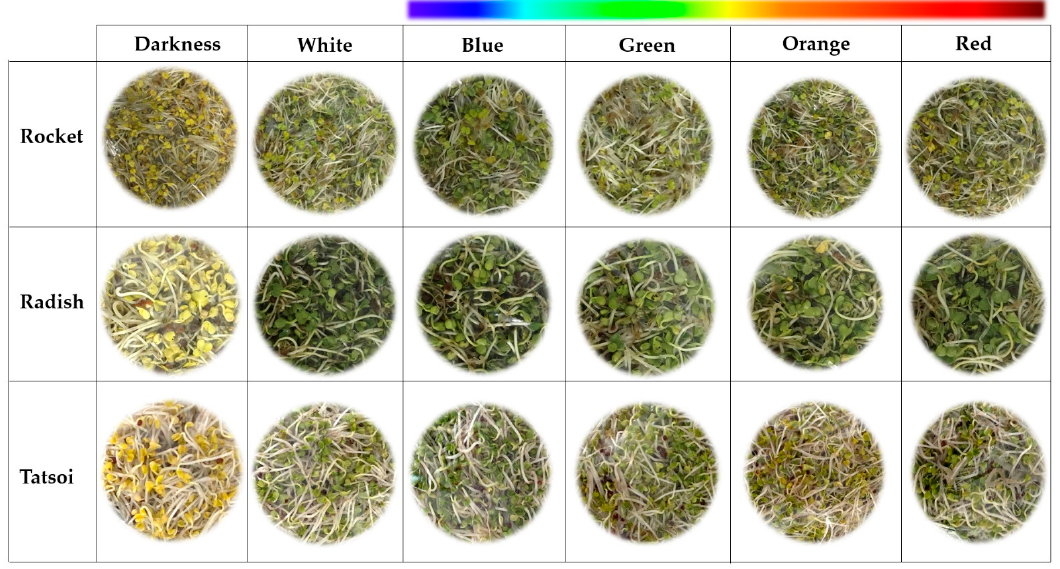
Figure 3. Color appearance of Brassicaceae sprouts after 5 days at 5 °C illuminated under different wavelengths of the electromagnetic spectrum. Table 1. Initial sprout characterization after 7 days growing.